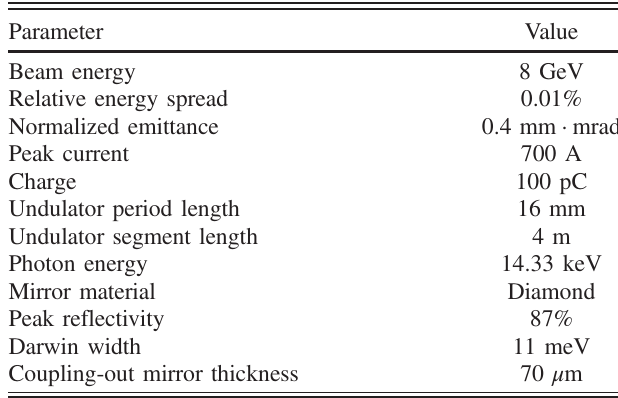
TABLE I. The main parameters of XFELO operation for